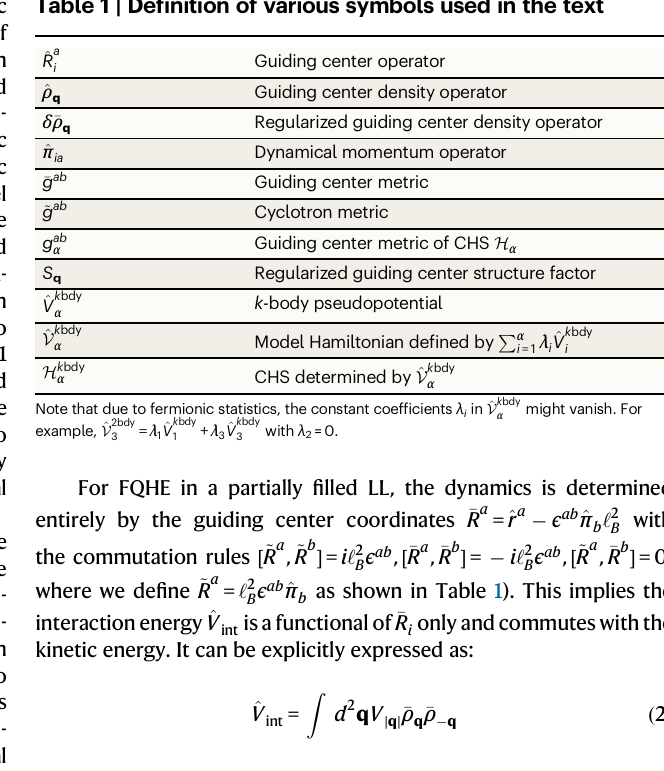
Table 1 | De fi nition of various symbols used in the